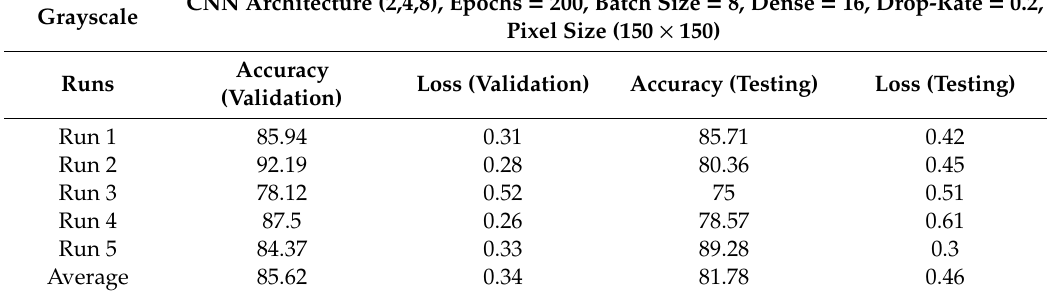
Table 9. CNN performance for grayscale